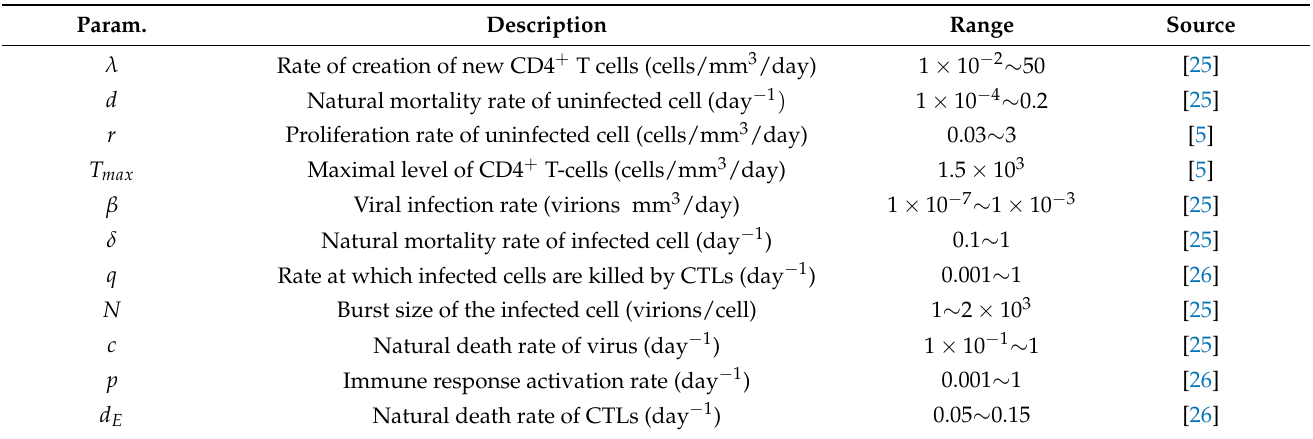
Table 1. The meaning and possible values of model